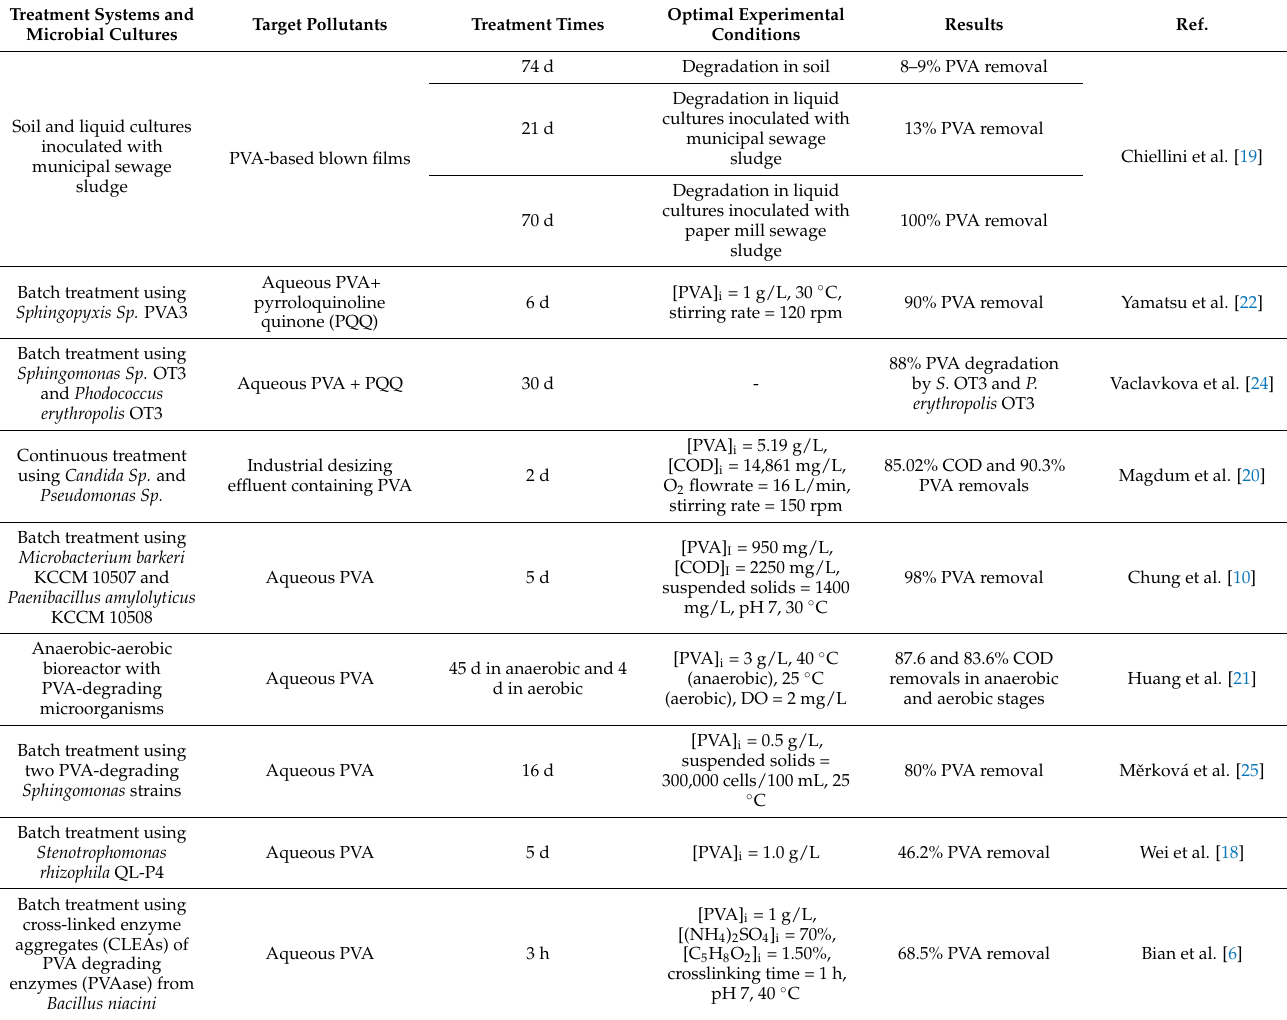
Table 1. Biological treatments of PVA-containing